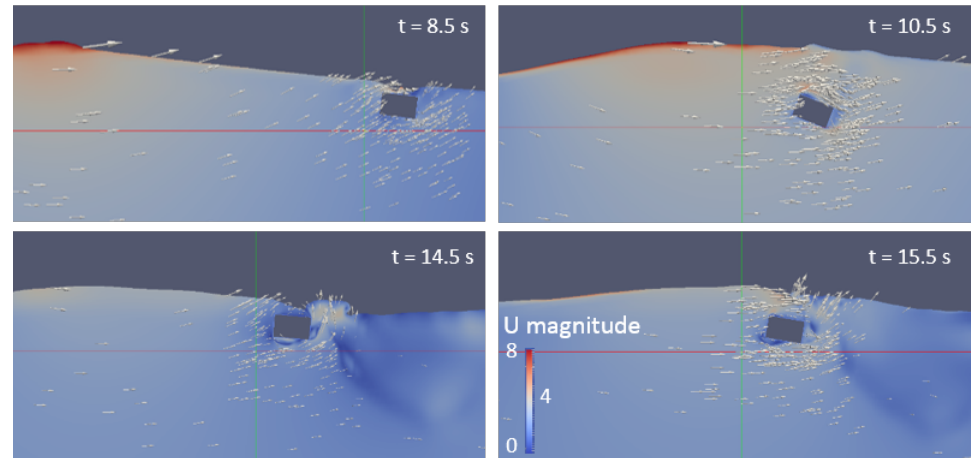
Figure 11. The WEC impacted by the tsunami wave. The figure shows the four main events: The first peak force occurred at t = 8.5 s, one second before the first wave peak propagated over the WEC at t = 10.5 s. The second peak force occurred at t = 14.5 s, one second before the second wave peak at t = 15.5 s. The origin marks the initial position of the